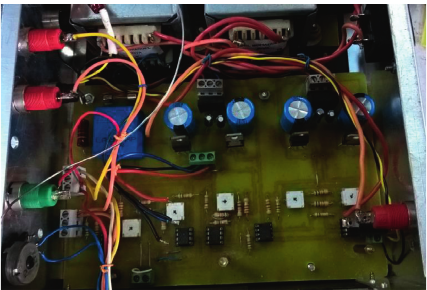
Figure 9: Overview of the card of hysteresis current